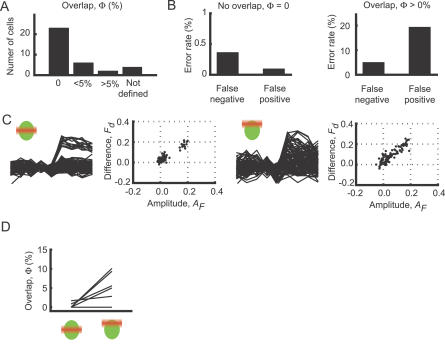
Validation of the Analysis Algorithms with Cell-Attached Recordings(A) The distribution of the overlap between the two ellipses for experiments with cell-attached recordings (n = 34 neurons). For some cells, the number of APs was too little to allow analysis (not defined).(B) For cells with zero overlap, the correspondence between scoring successes and failures from imaging experiments and APs was very high (left). For cells with overlap, false-positive and false-negative trials were often detected (graph on right). Note the differences in y-axes between the two graphs.(C) The location of the focal plane within the soma affects detection fidelity. When the focal plane was centered on the soma (left), successes and failures were clearly distinguishable. In the same cell, when the focal plane was closer to the upper edge of the cell (right), the two clusters were less segregated.(D) The overlap increases, and detection fidelity decreases, as the focal plane is moved from the center of the soma, closer to the edge.